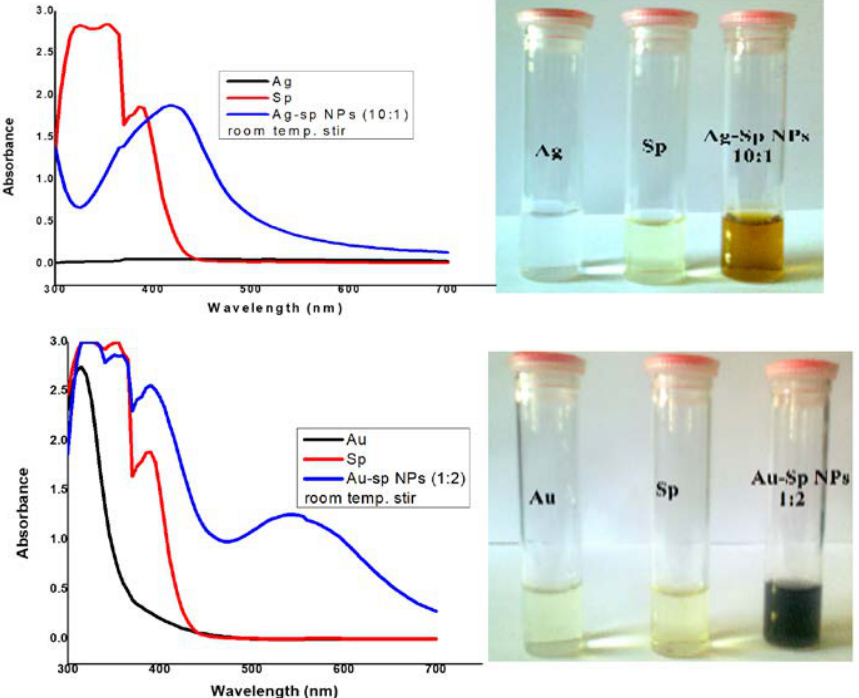
Fig. 2. (a) UV-Vis spectra of optimized Ag-Sp NPs, optical recognition of synthesized silver NPs in inset, (b) UV-Vis spectra of optimized Au-Sp NPs, visual inspection of synthesized gold NPs in inset and the inset photo shows the visual inspection of synthesized gold